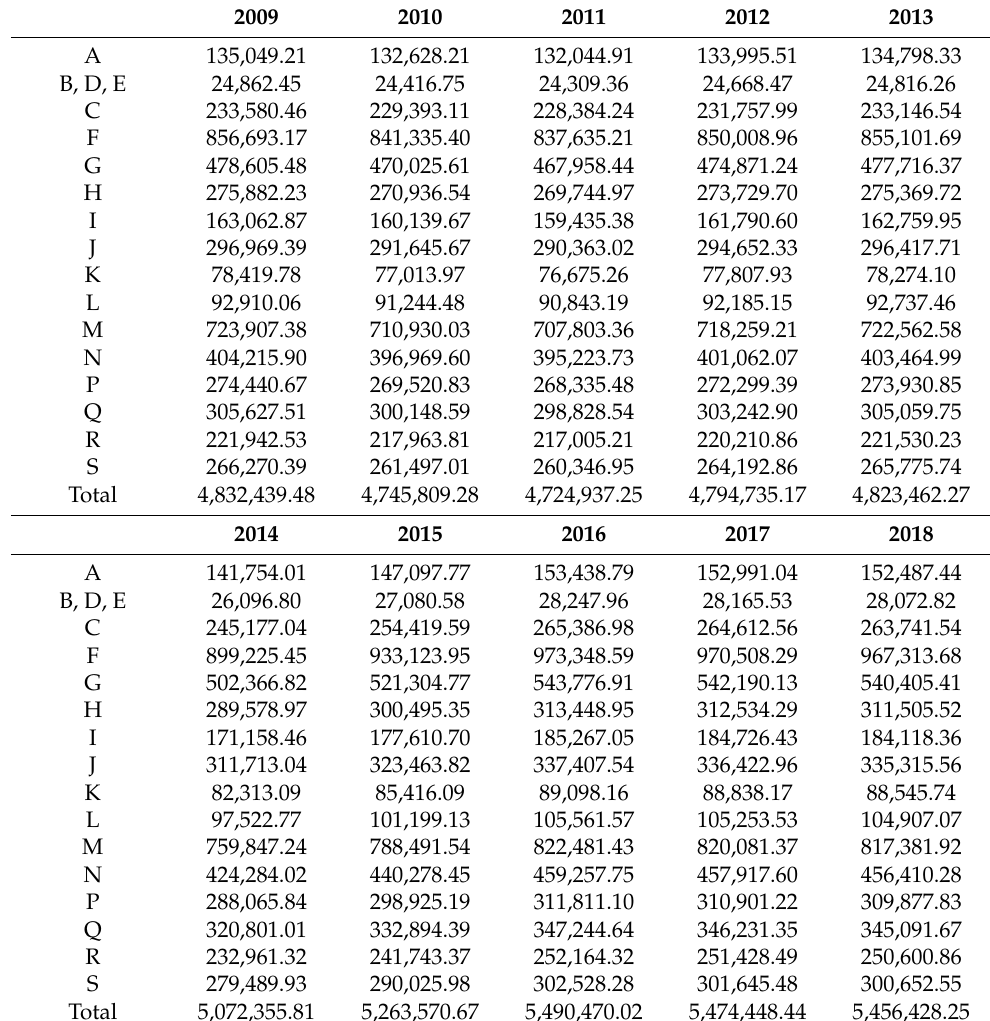
Table 7. Total number of enterprises in the United Kingdom